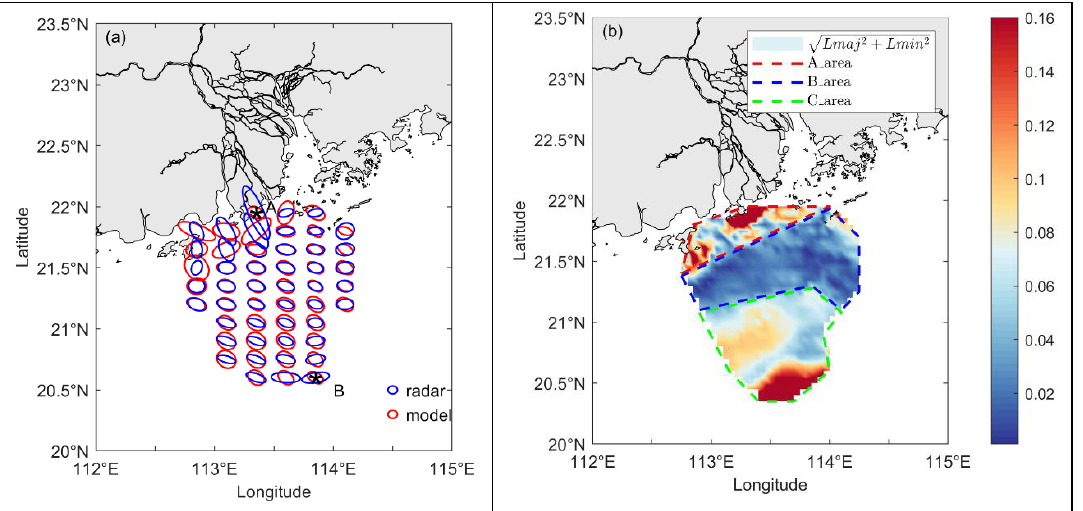
Figure 2. ( a ) EOF ellipses calculated from the HF radar (blue) currents and model (red) currents within the radar observing area. The data points are plotted at 0.25° × 0.15° intervals. Point A the radar observing area. The data points are plotted at 0.25 ◦ × 0.15 ◦ intervals. Point A (113.35 ◦ E, (113.35°E, 21.95°N) and point B (113.85°E, 20.6°N) are marked with “ * ”. ( b ) Errors between the radar 21.95 ◦ N) and point B (113.85 ◦ E, 20.6 ◦ N) are marked with “*”. ( b ) Errors between the radar and and model ellipse were calculated using √(L𝑚𝑎𝑗 𝑟𝑎𝑑𝑎𝑟 − L𝑚𝑎𝑗 𝑚𝑜𝑑𝑒𝑙 ) 2 + (L𝑚𝑖𝑛 𝑟𝑎𝑑𝑎𝑟 − L𝑚𝑖𝑛 𝑚𝑜𝑑𝑒𝑙 ) 2 , (cid:113) ( L maj − L maj ) 2 + ( L min − L min ) 2 , where model ellipse were calculated using where L maj and L min denote the major and minor axes of the ellipses. radar model radar model L maj and L min denote the major and minor axes of the